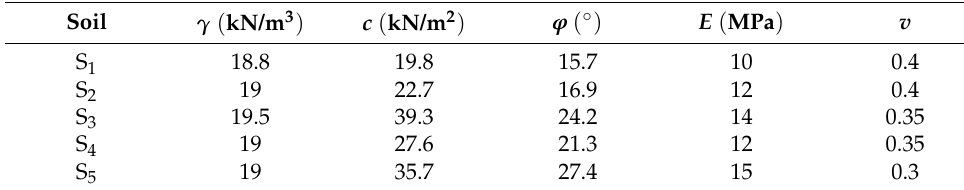
Table 3. Mechanical parameters of Section 5.3.